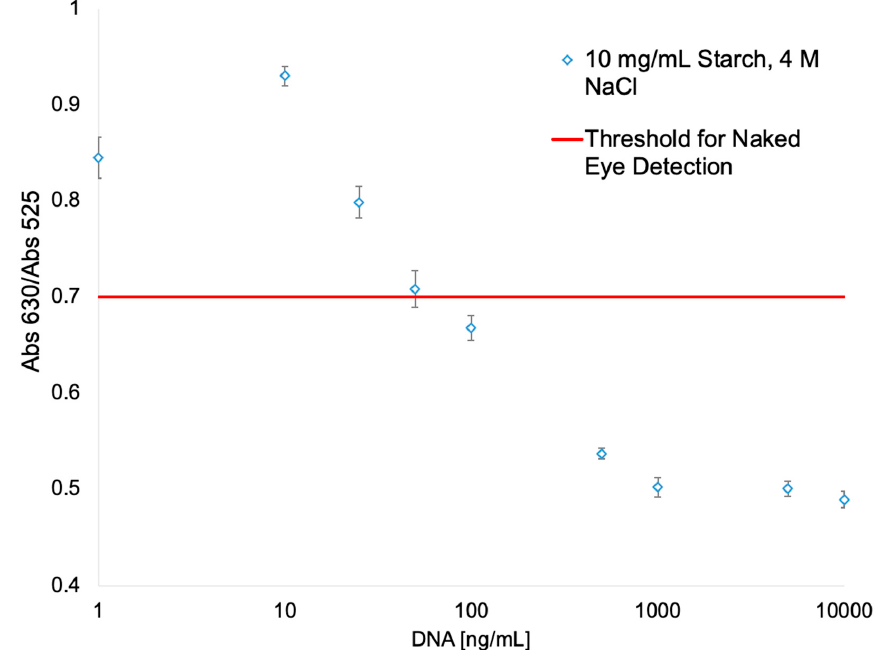
Figure 6. Plot of DNA concentration versus absorbance ratio (Abs 630 /Abs 525 ) for the biosensor assay. The red line indicates the threshold at which the naked eye can detect the change in color of the AuNPs solution.